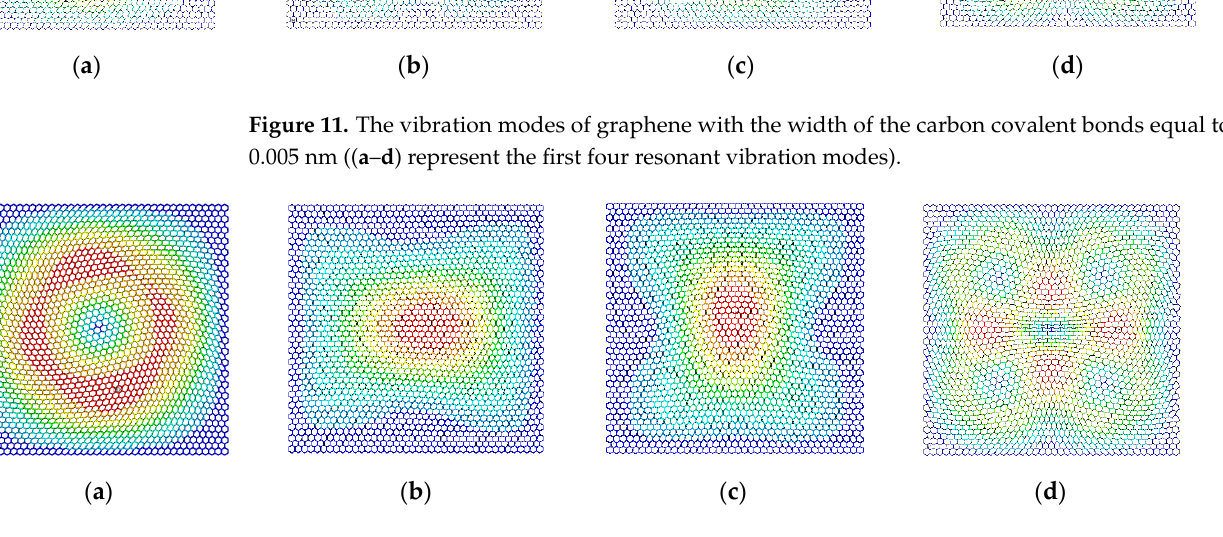
Figure 12. The vibration modes of graphene with the width of the carbon covalent bonds equal to 0.02 nm (( a – d ) represent the first four resonant vibration modes).